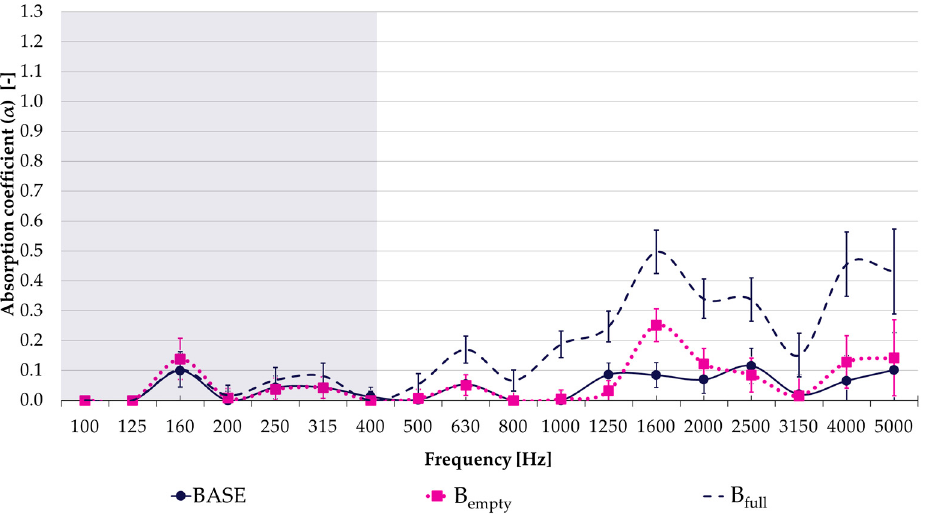
Figure 11. The obtained random incidence sound absorption coefficients of the BASE, B empty , and B full configurations, together with the standard deviations of the results for each sample configuration.